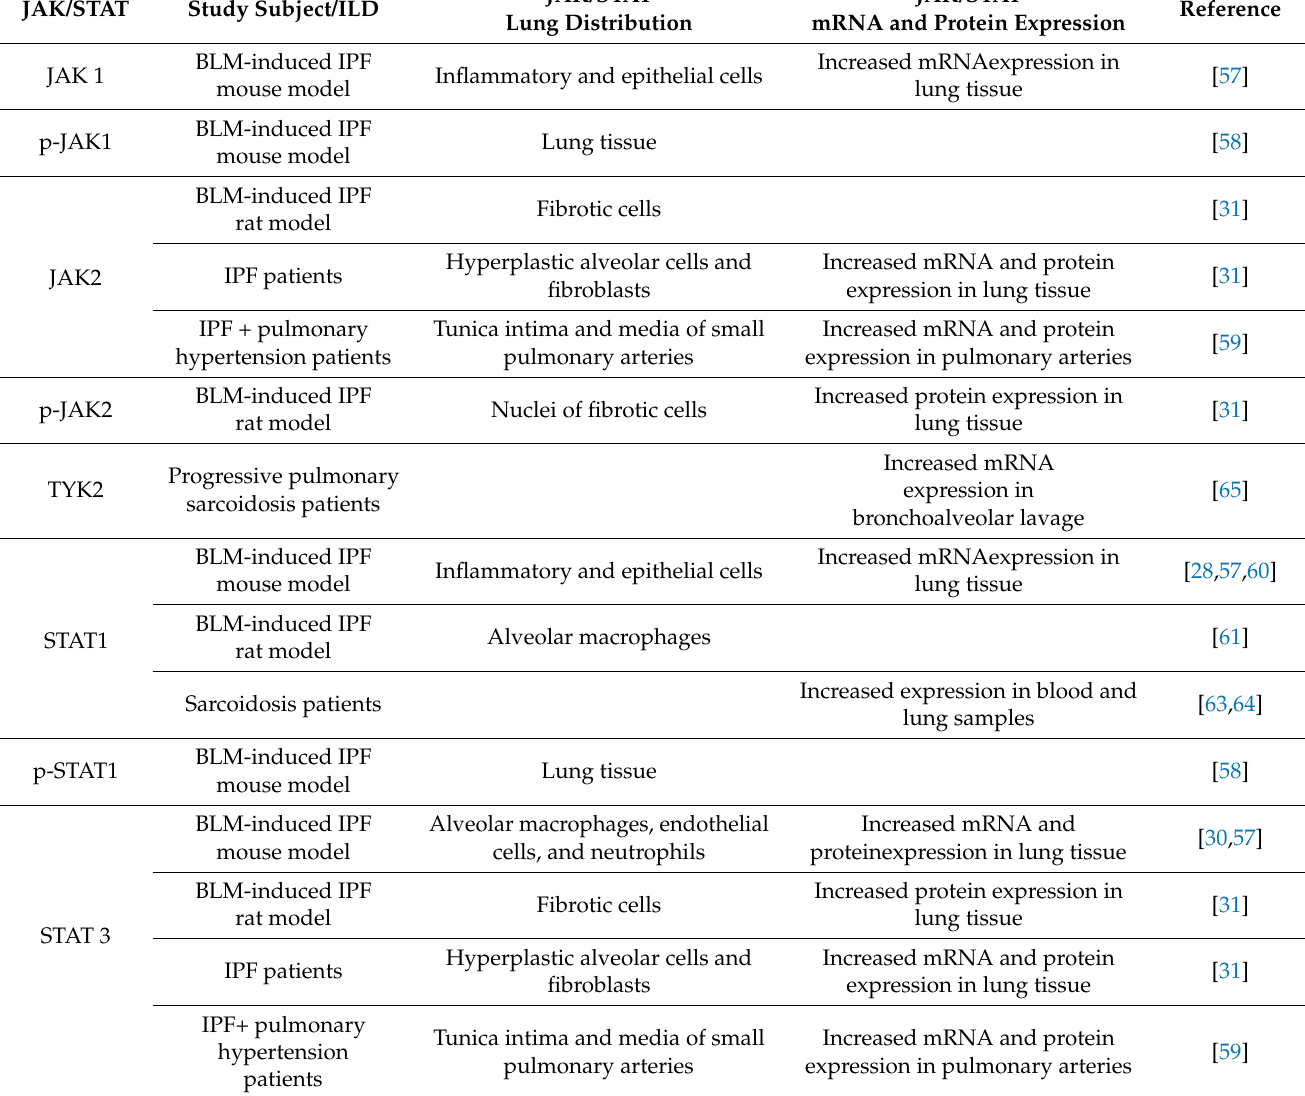
Table 3. Summary of JAK/STAT expression and distribution